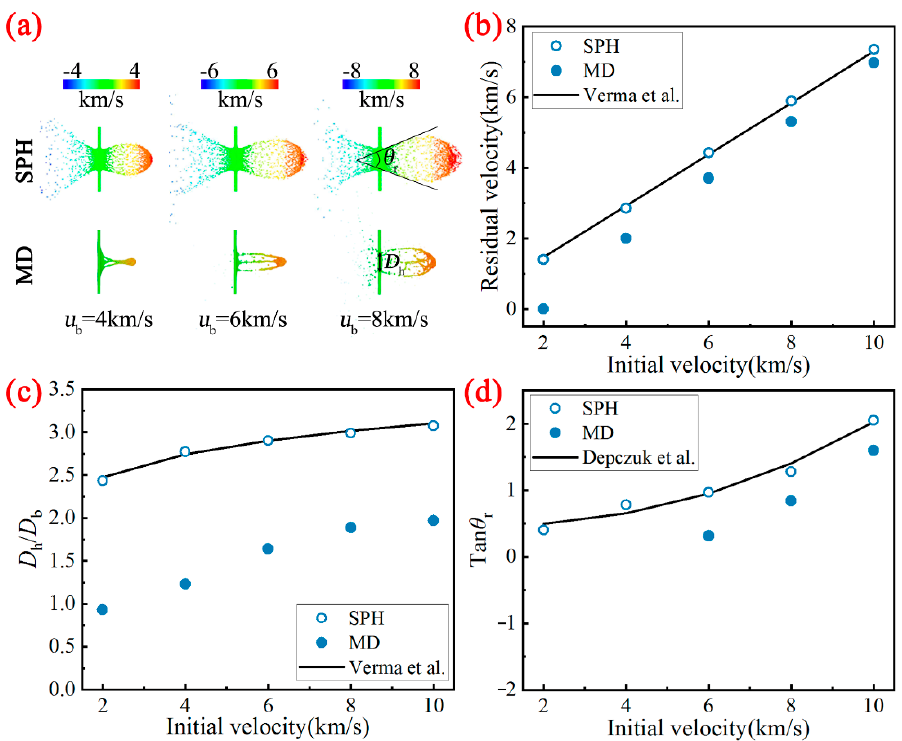
Figure 7. Comparison of ( a ) the morphology of debris clouds, ( b ) residual velocity, ( c ) crater diameter and ( d ) expansion angle between MD and SPH at different initial velocities.